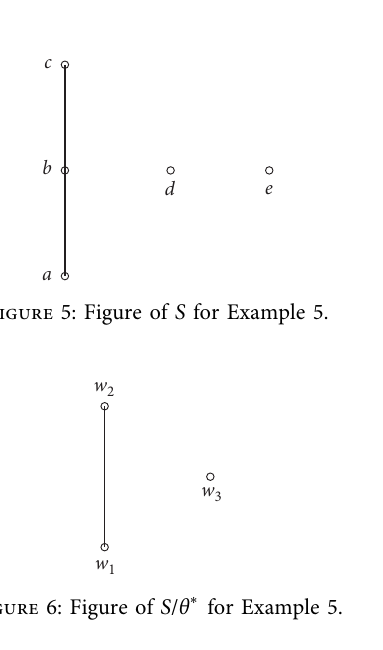
Figure 6: Figure of S / θ ∗ for Example 5.